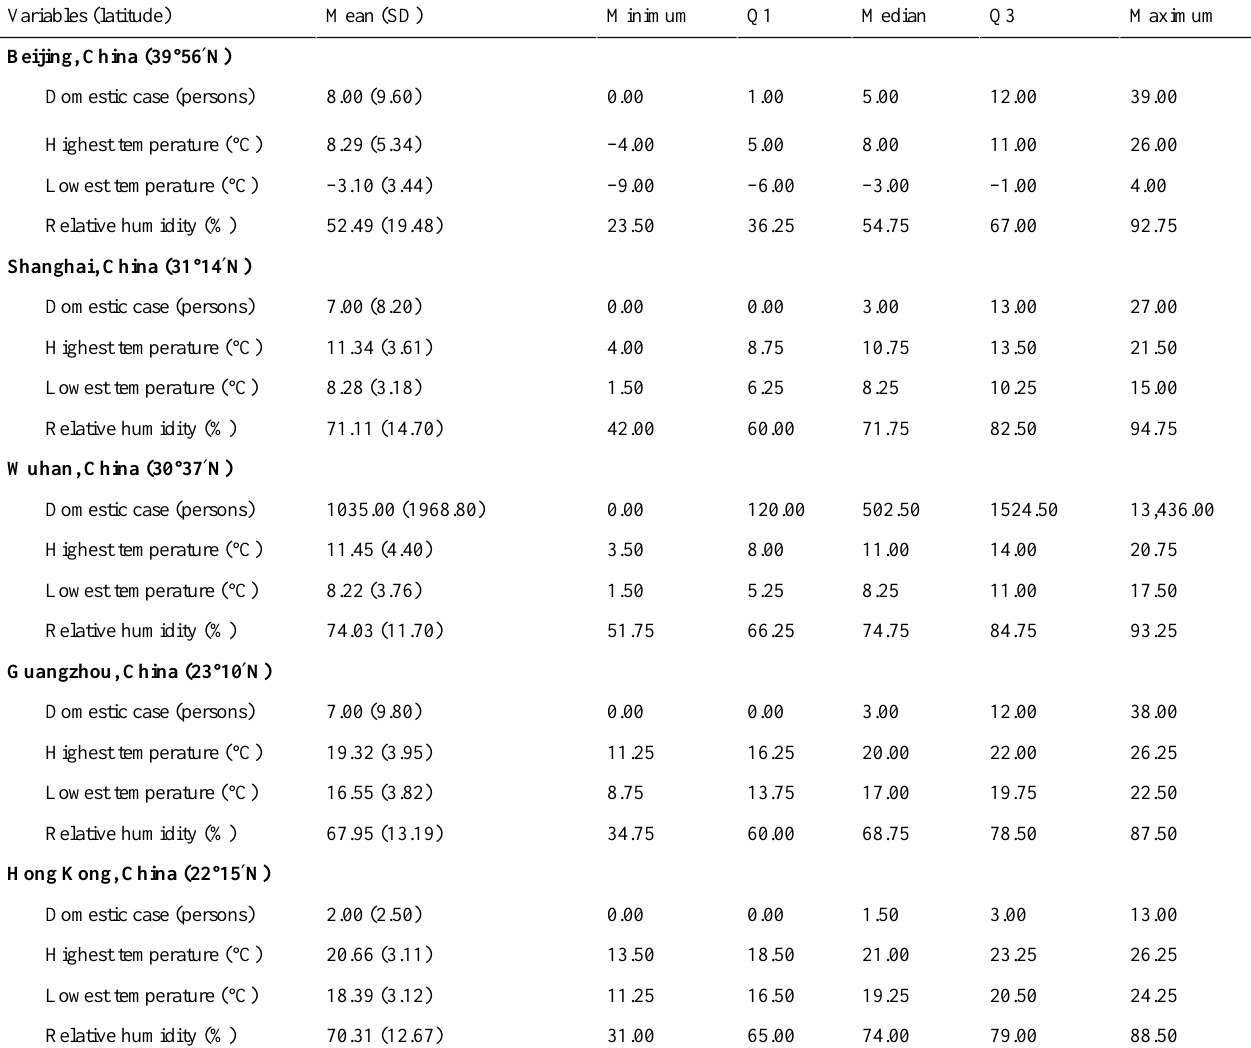
Table 1. Descriptive statistics for different Asian